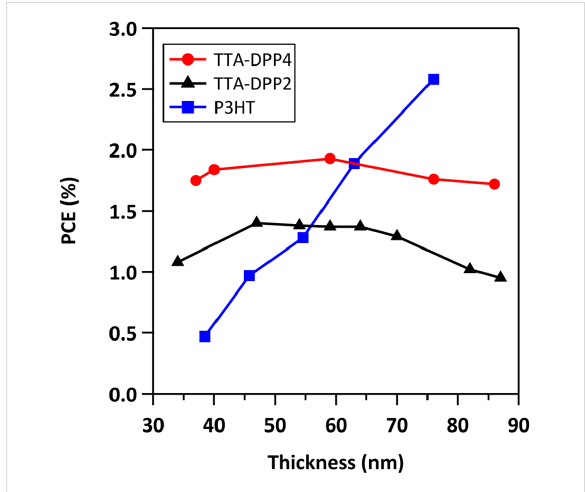
Figure 6: Relationship between active layer thickness and power conversion efficiency (PCE) for TTA-DPP4, TTA-DPP2, and P3HT- based BHJ-OSCs (see also Figures S2–S4 in the Supporting Informa- tion File 1 for detailed photovoltaic